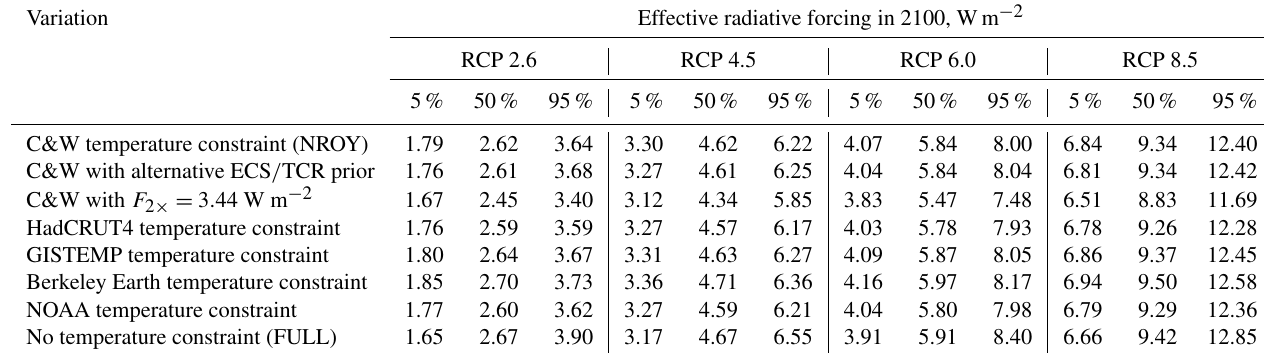
Table 8. Sensitivity in the effective radiative forcing to variations in the underlying assumptions in the FAIR large ensemble.